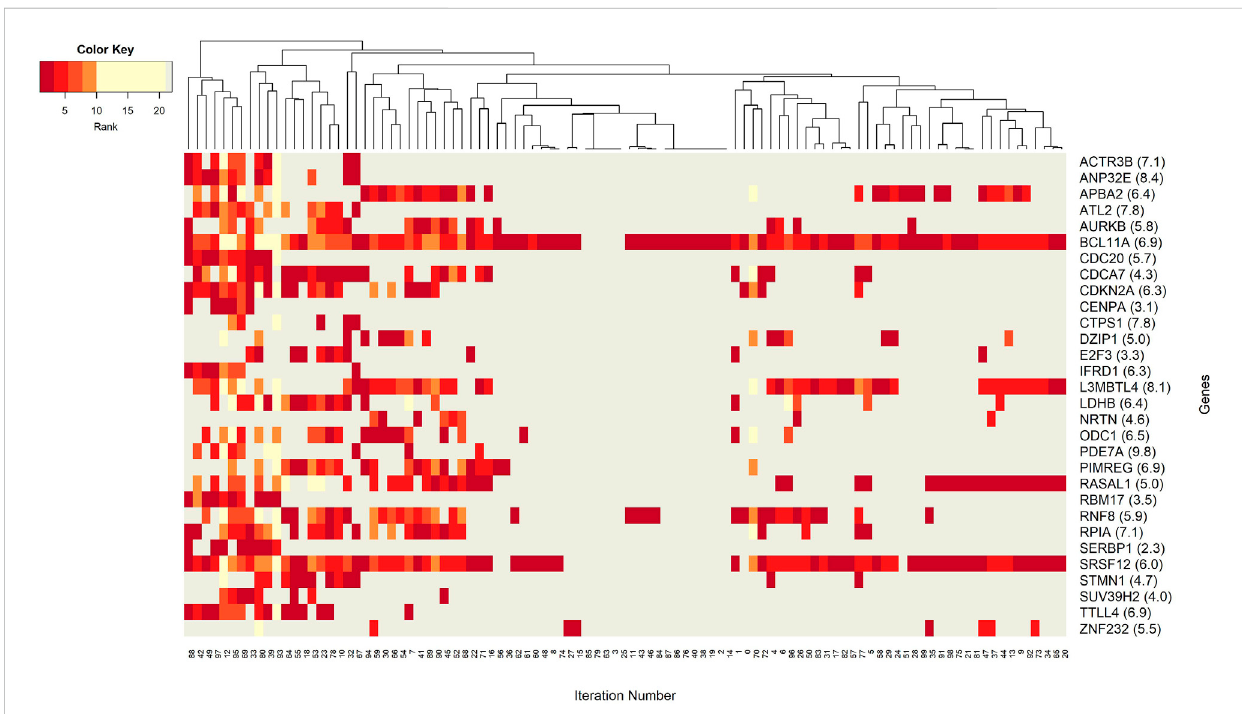
FIGURE 6 Heatmap of gene features with rank information for each split. Heatmap reveals patterns of co-occurrence of genes over different splits. Rank of each gene is illustrated using colors. Gray color is used to denote non-detected